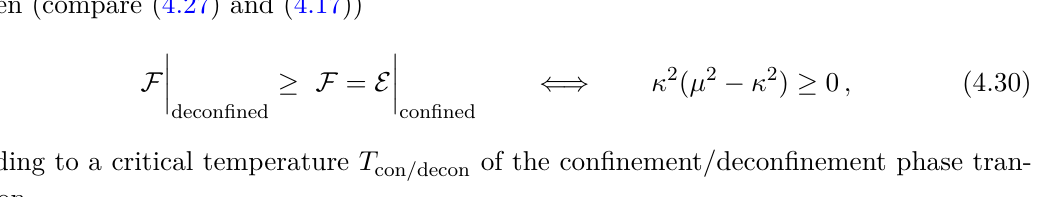
Figure 4 . The phase diagram of black holes in AdS 5 Casimir energy density is shown as a function of κ/µ . κ determines the Hawking temperature E 0 of the black hole, see